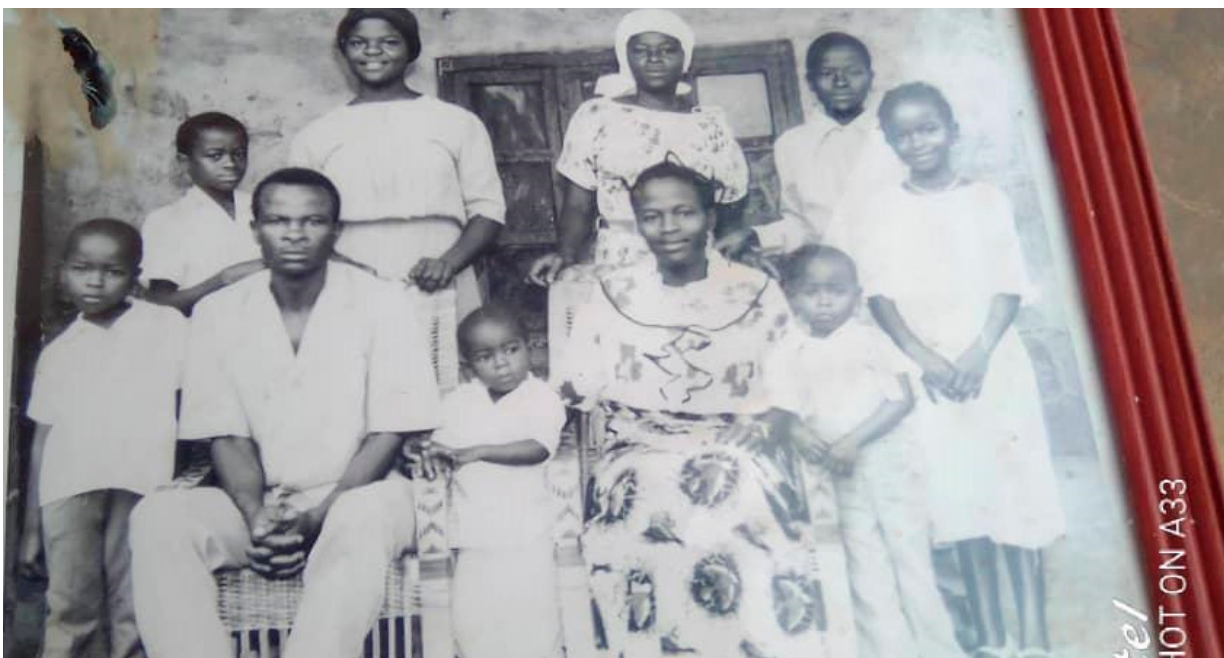
Figure 6. The family of a teacher and his family.